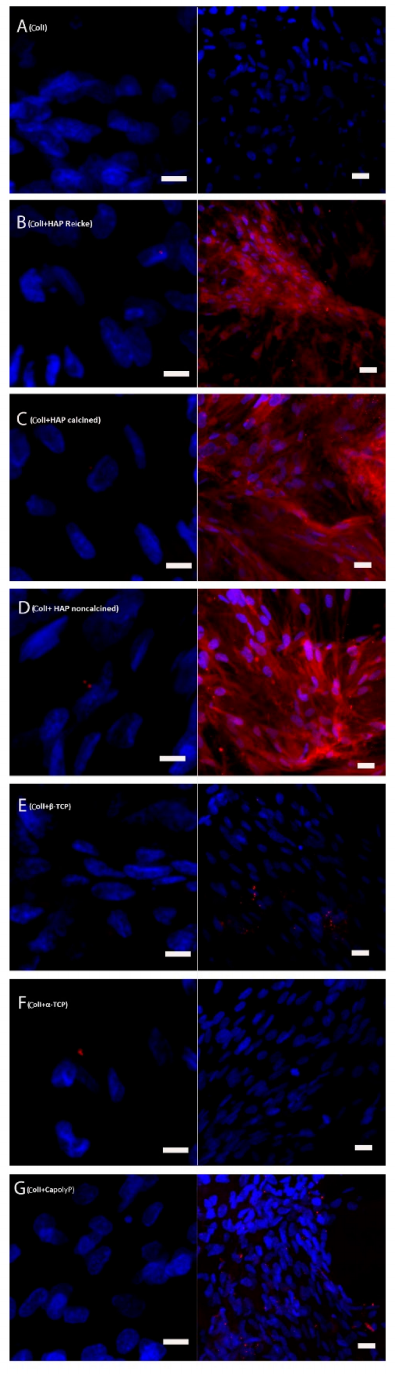
Figure 6. Bone extracellular protein osteocalcin expression on day 21 (left column) and day 35 (right column). Cell nuclei visualized with Hoechst, osteocalcin red. Cells seeded on: Coll ( A ), ColI+HAP Reicke ( B ), ColI+HAP calcined ( C ), ColI+HAP noncalcined ( D ), ColI+ β -TCP ( E ), ColI+ α -TCP ( F ) and ColI+CapolyP ( G ). Scale bar 10 µ m (day 21), 20 µ m (day